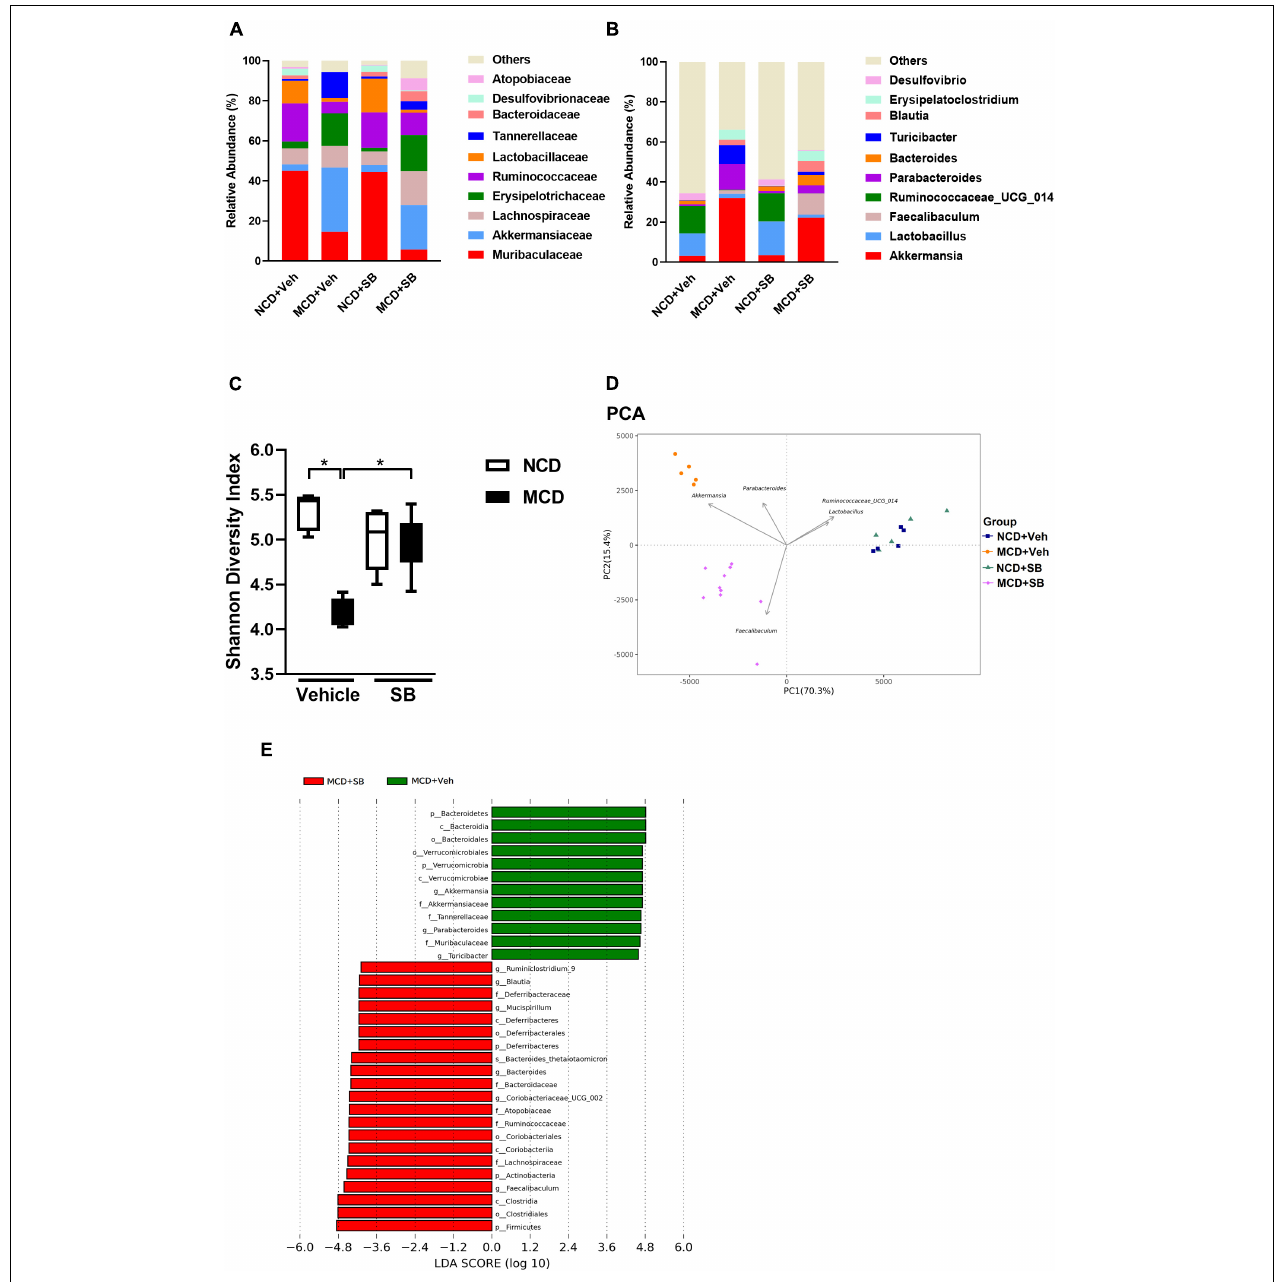
FIGURE 7 | SB affected the microbial configuration and restored intestinal microbiota diversity in the MCD diet-fed mice. (A) Topmost abundant taxa at the family level and (B) genus level. (C) The Shannon diversity index represents alpha diversity. (D) PCA represents beta diversity at the genus level. Each symbol represents one sample ( n = 5–10 per group). (E) Discriminative biomarkers with an LDA score >